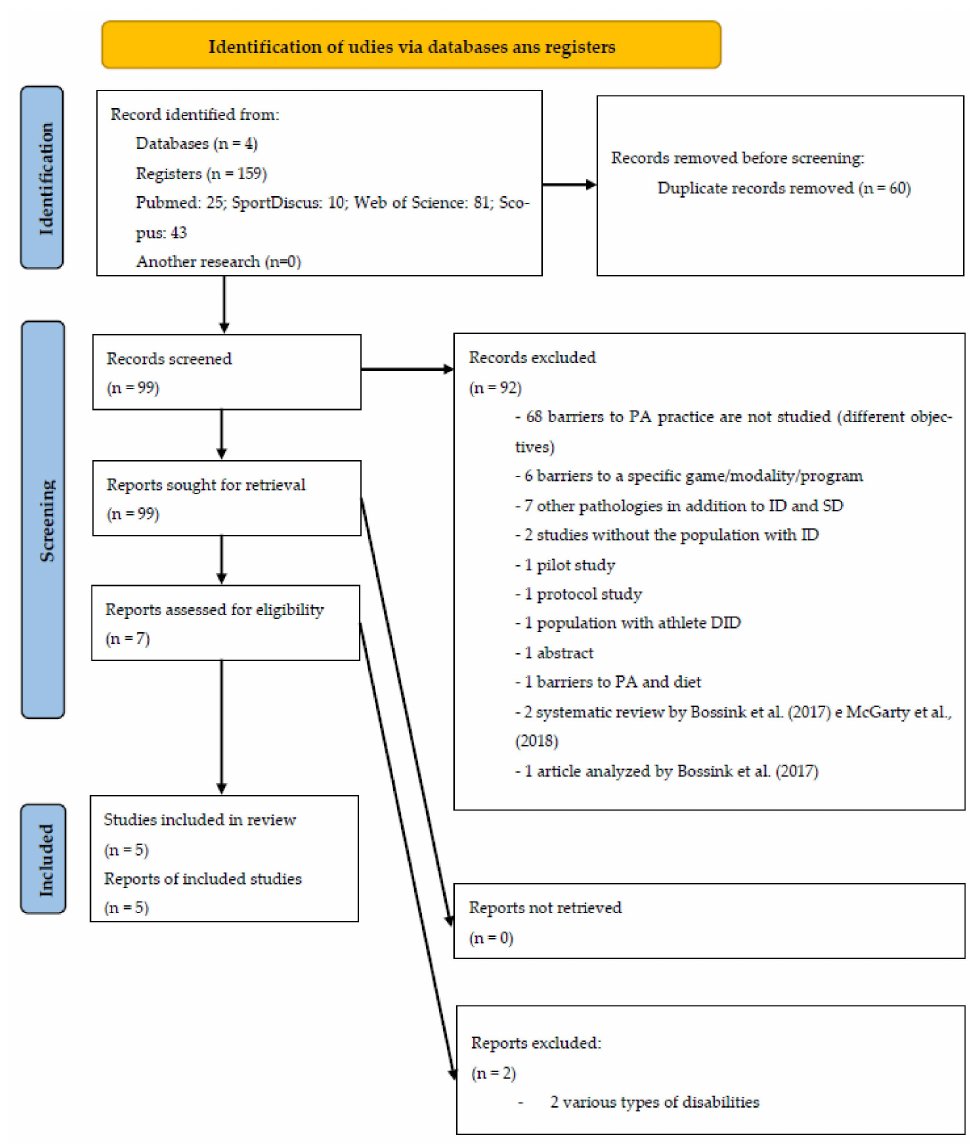
Figure 1. PRISMA flow diagram illustrating each phase of the search and selecting